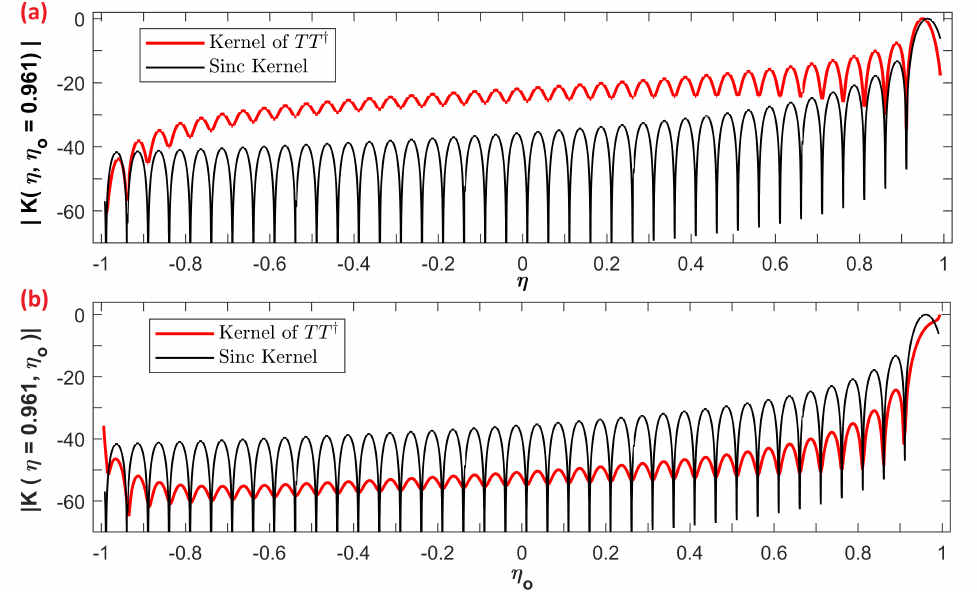
Figure 7. ( a ) Kernel of T T † in terms of η for η o = η ( X o ) , and sinc kernel in terms of η for η o = η ( X o ) . ( b ) Kernel of T T † in terms of η o for η = η ( X o ) , and sinc kernel in terms of η o for η = η ( X o ) . The diagrams are in dB, and they refer to the configuration a = 10 λ , z o = 5 λ , X o = 20 λ ( η ( X o ) = 0.961).